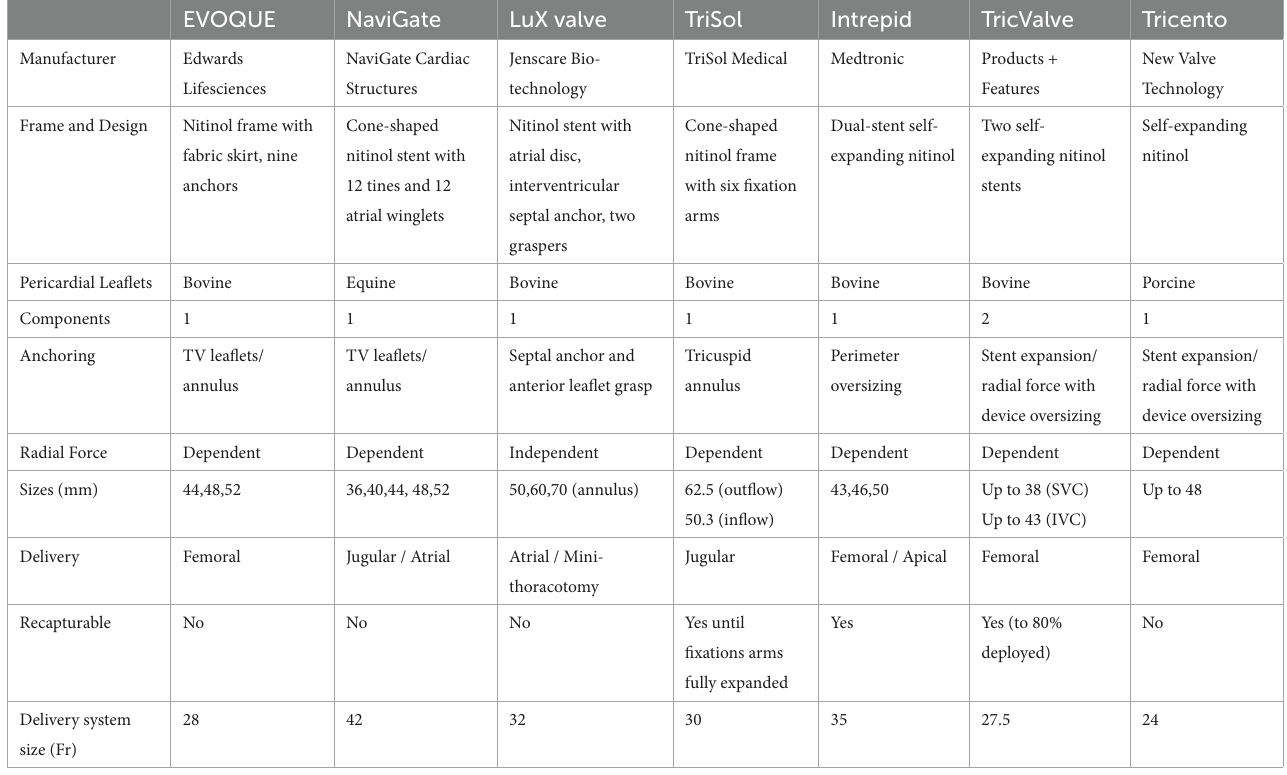
TABLE 3 Summary of orthotopic and heterotopic tricuspid valve replacement device